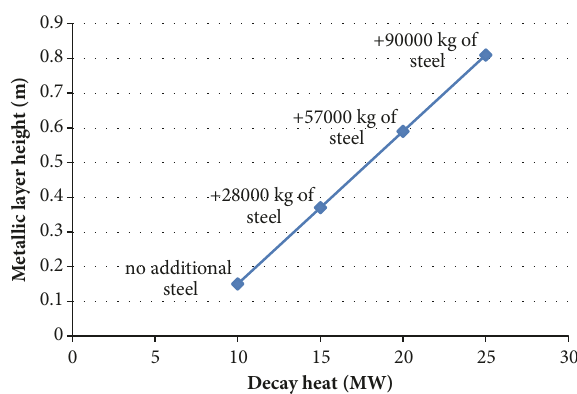
Figure 20: Decay heat versus metallic layer height, required to achieve heat flux equal to